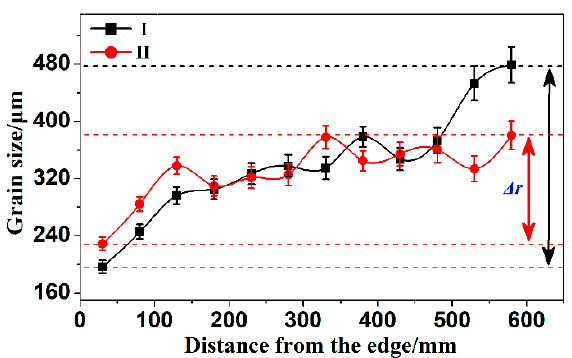
Figure 4. Grain size distribution plots of the two ingot cross-sections.